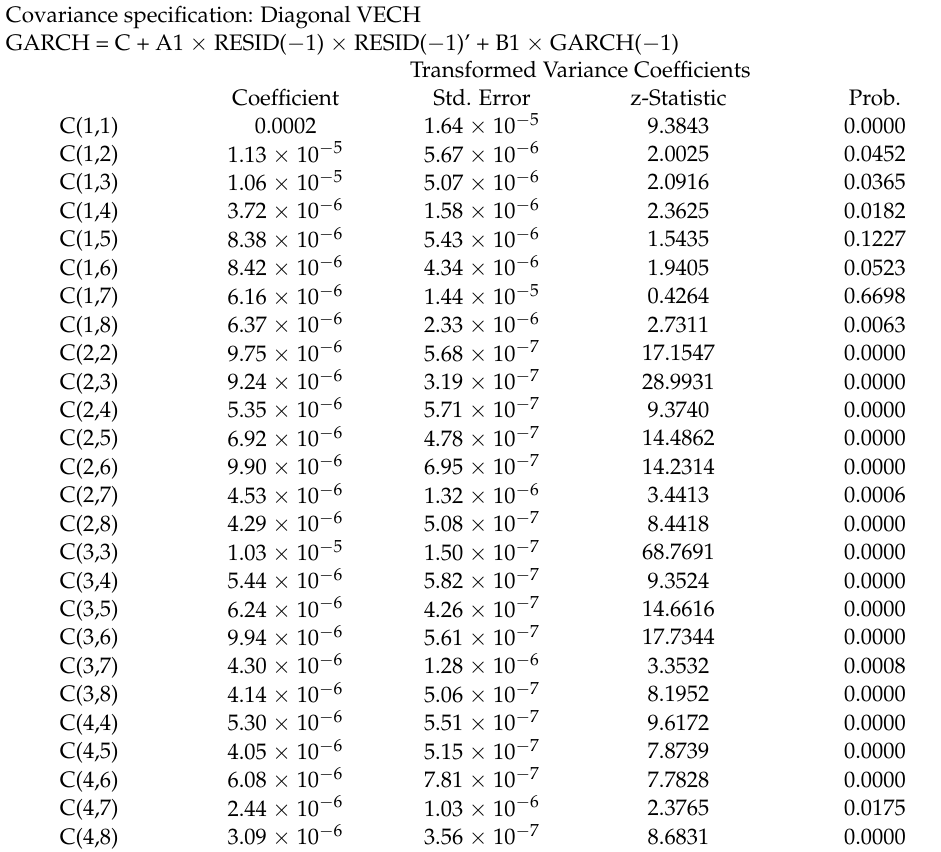
Table A1. D-VECH model results (Bitcoin-G7 indices). Covariance specification: Diagonal